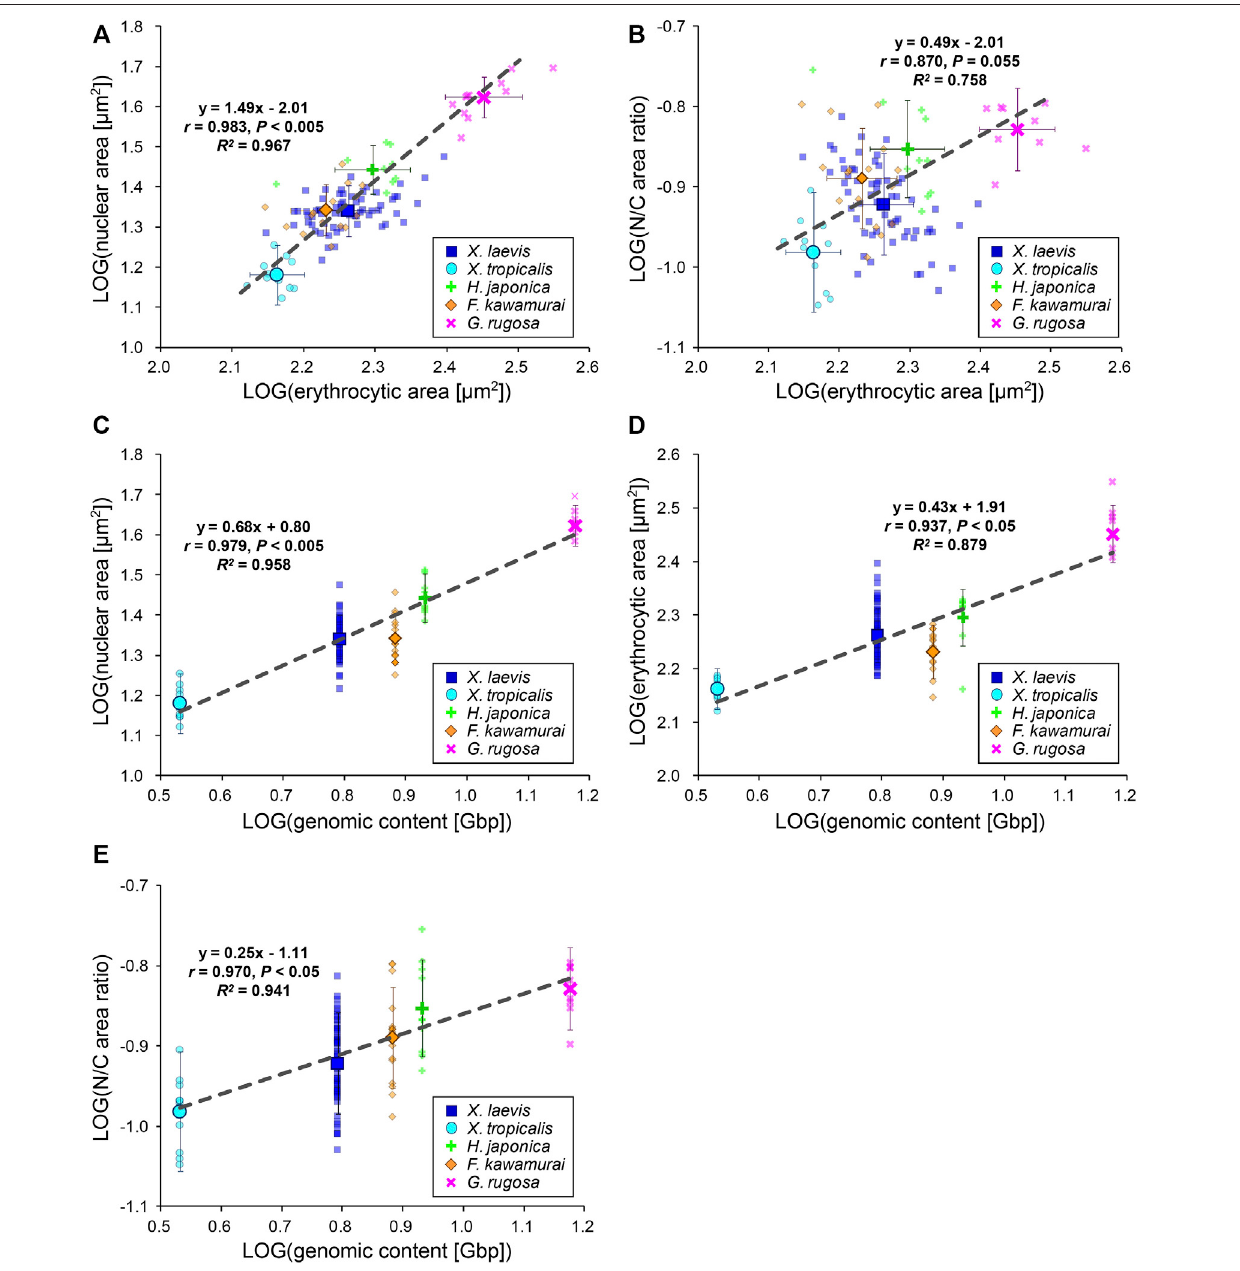
FIGURE3| Inter-speciesrelationshipamongnucleararea,erythrocyticarea,andgenomiccontentin fi vefrogspecies. (A) Calculatedmeannuclearcross-sectional areas and (B) calculated mean N/C area ratios of each species were plotted against the mean erythrocytic cross-sectional areas in a log-log plot. (C) Calculated mean nuclearcross-sectionalareas, (D) meanerythrocyticcross-sectionalareas,and (E) meanN/Carearatiosfromeachspecieswereplottedagainstthegenomiccontentin a log-log plot. The mean data from each frog (small symbols) and mean data from each species (big symbols; ±SD) have been shown, along with the equation for the regression line, Pearson ’ s correlation ( r ), P values, and coef fi cient ofdetermination ( R 2 ) in each plot. The regression lines were calculated using mean data from each species. X. laevis : n = 62; X. tropicalis : n = 11; H. japonica : n = 10; F. kawamurai : n = 16; G. rugosa : n = 11.